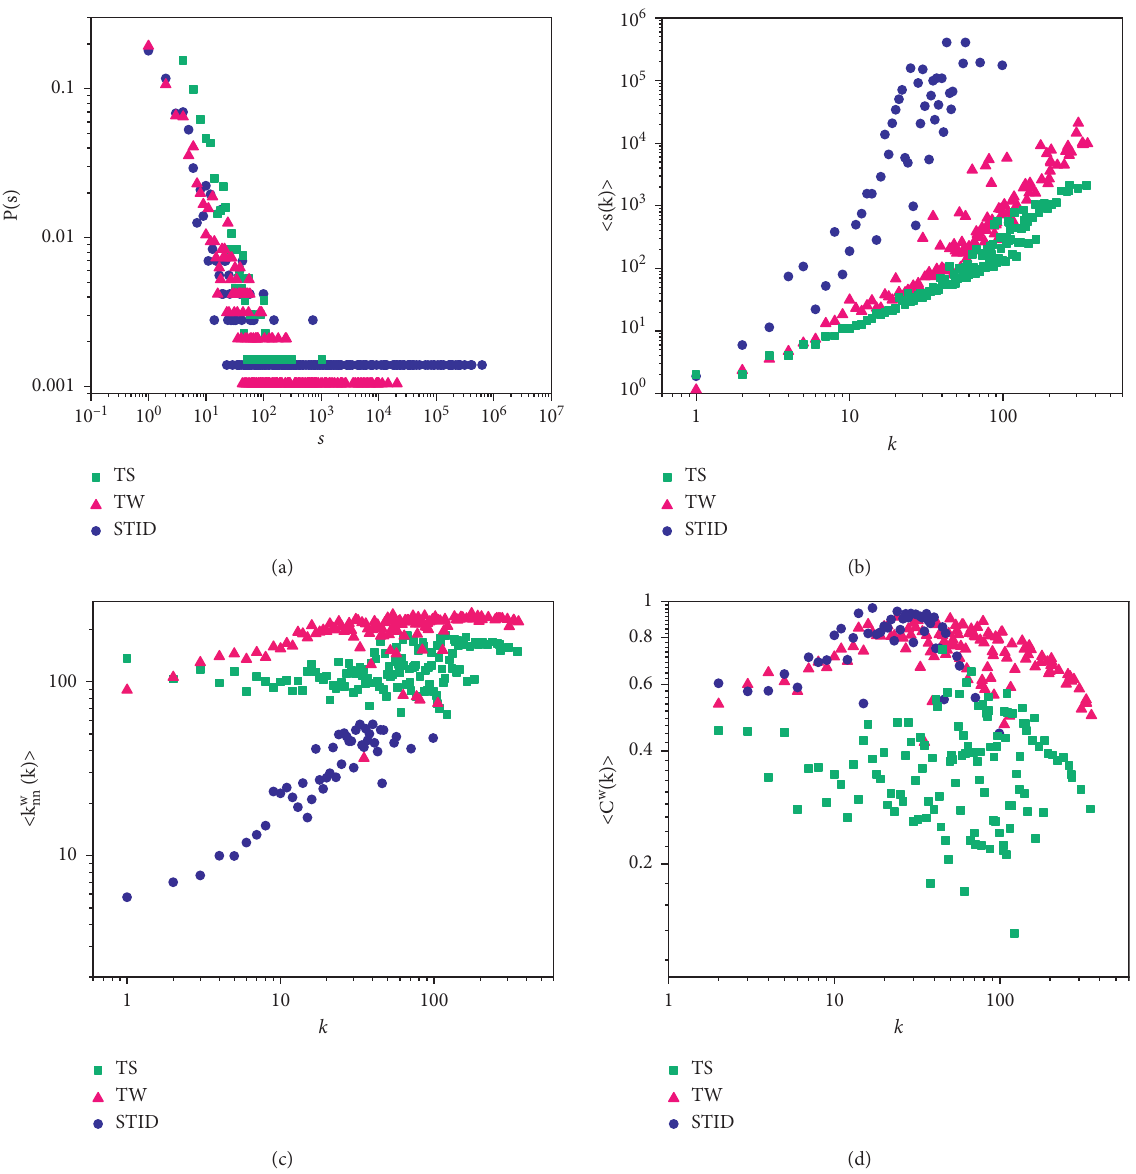
Figure 7: The weighted properties of the networks. (a) Strength distribution. (b) Plot of the average nodal strength 〈 s ( k )〉 against the degree k . (c) Weighted average neighbor degree 〈 k w 〉 against the degree k . (d) Weighted average clustering coefficient 〈 C w ( k )〉 against the degree nn k . The green squares, pink triangles, and blue dots represent TS, TW, and STID